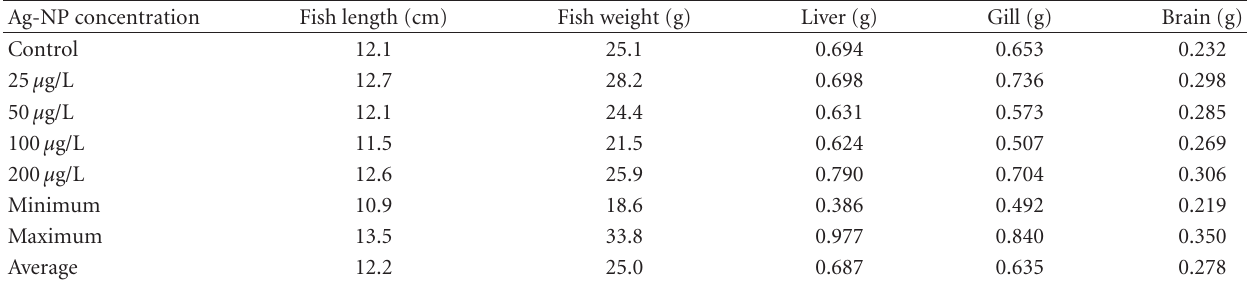
Table 1: Measurements of the common carp used in the